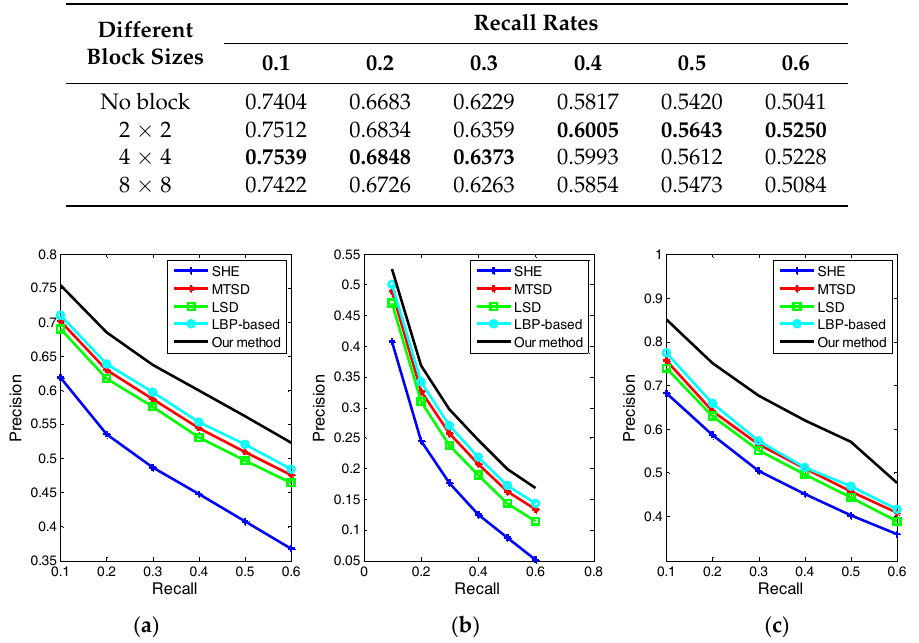
Table 3. Retrieval precision of different block sizes on the database Corel-1k with { λ 1 = 1, λ 2 = 1 } .